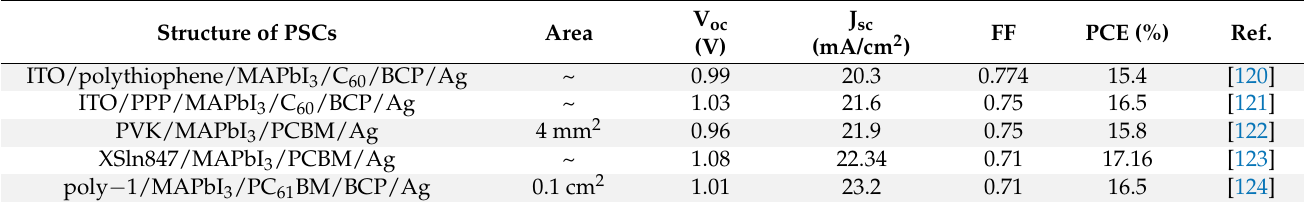
Table 10. Performances of several representative inverted PSCs on the basis of other conductive polymers